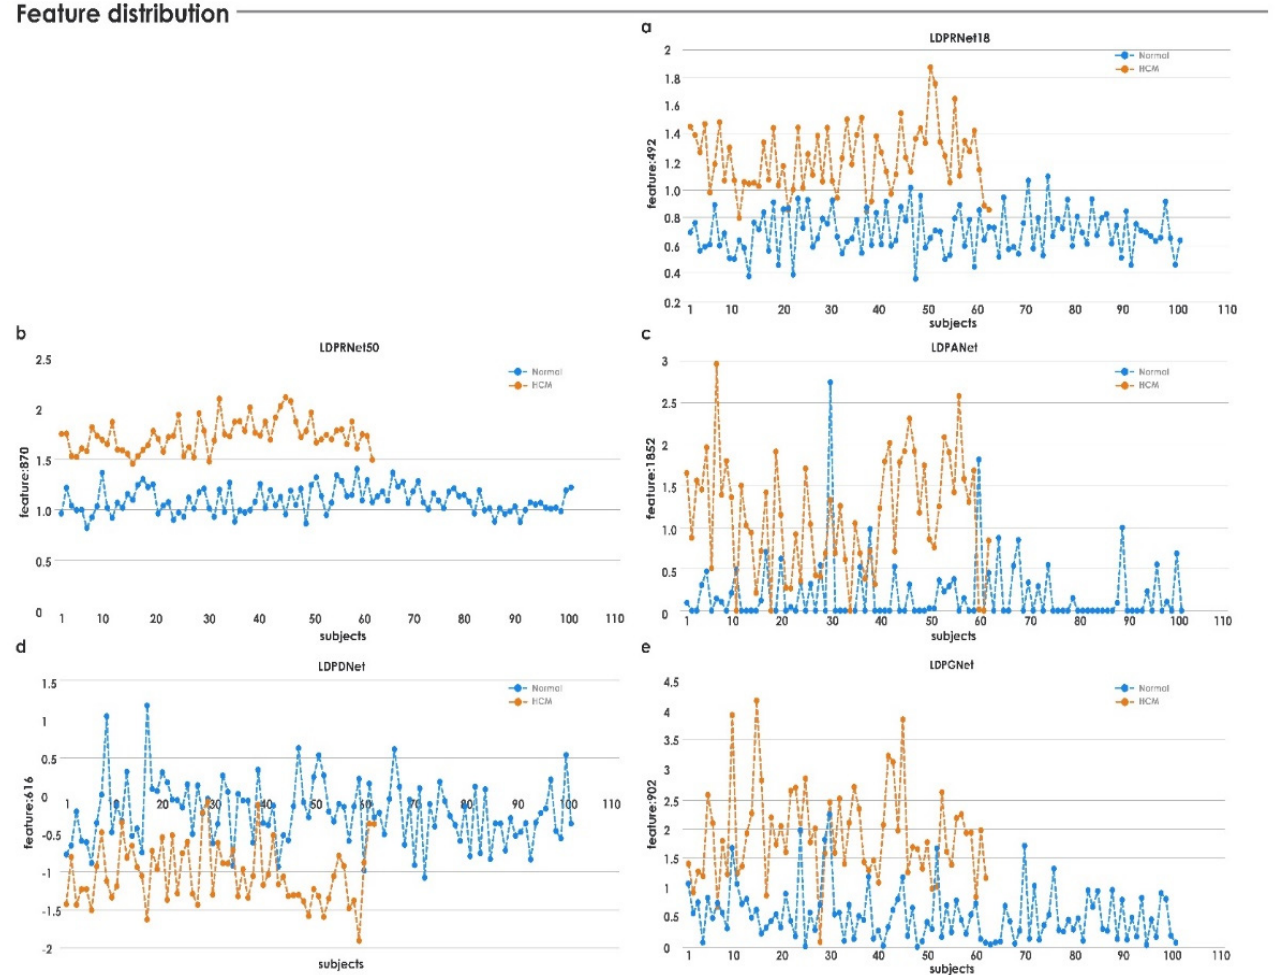
Figure 9. Distributions of the highest-ranked features obtained from the various methods.